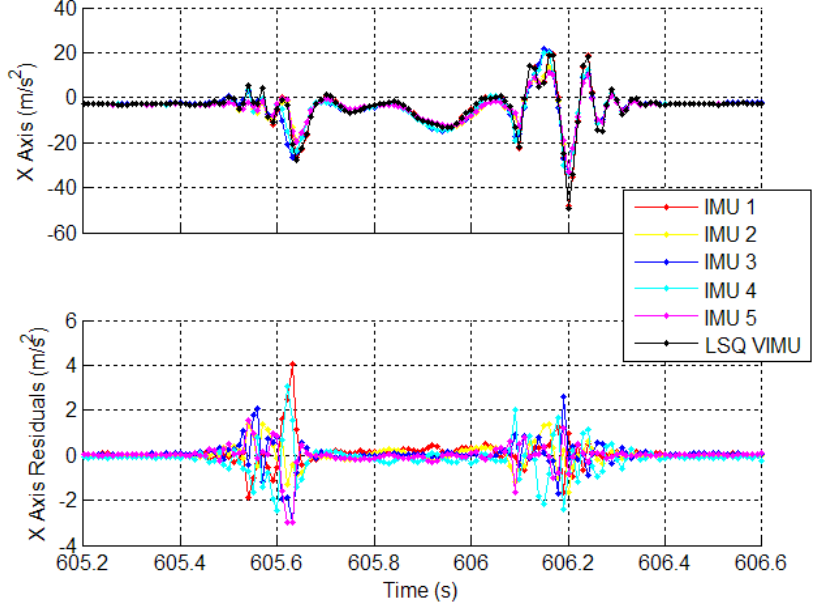
Figure 2. Specific Force Residuals from a Virtual IMU Computed from Least-Squares